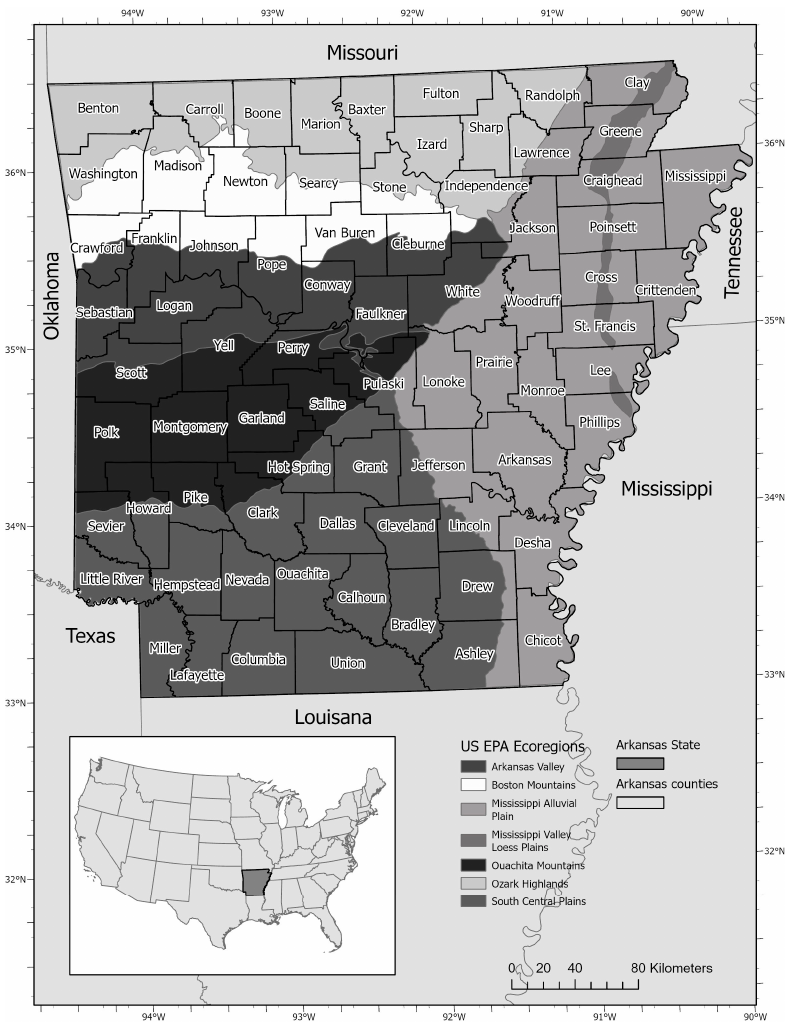
Figure 1. The study area of Arkansas. Table 3. Statistical summary for the health, socioeconomic, demographic, and environmental factors with the yearly temporal